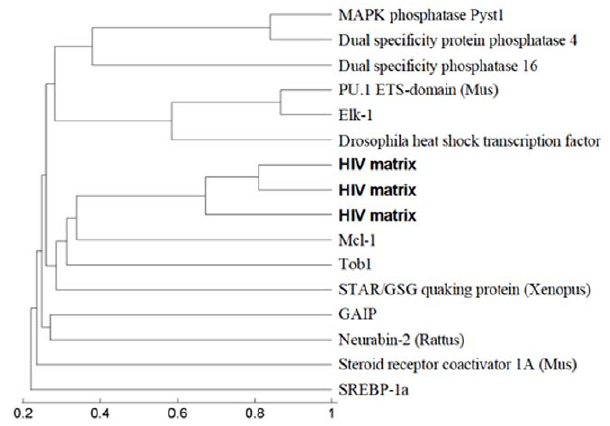
Figure 4. MAPK substrate hierarchy. Here we present UPGMA clustering of HIV MA proteins and ERK1/2 substrates by pairwise structural alignment TM-scores. All substrates are human proteins unless otherwise indicated. The HIV MA proteins are shown in bold.